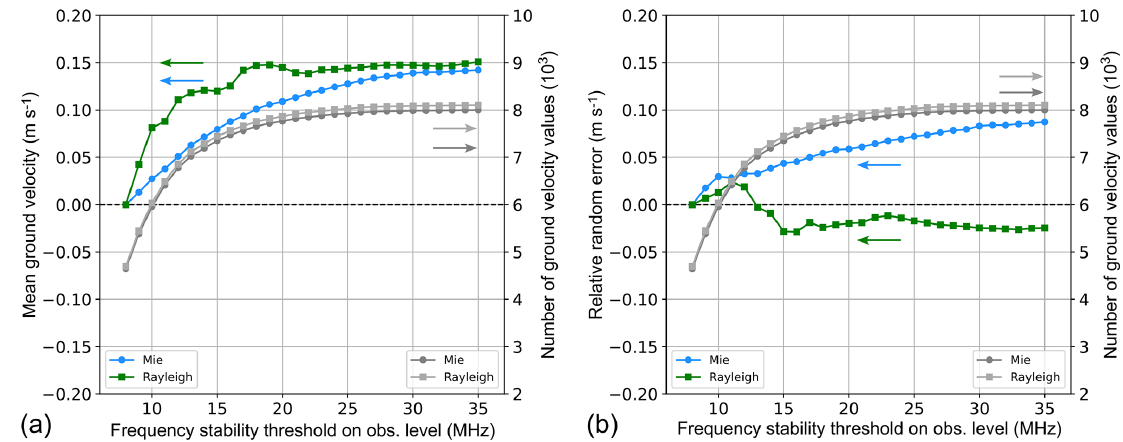
Figure 15. Mean ground velocity (a) and relative random error (b) of the Mie (blue dots) and Rayleigh channel (green squares) depending on a frequency stability threshold for the combined periods from 17 to 24 August 2020 and from 28 September to 5 October 2020. The data were subtracted by the respective values obtained for a threshold of 8MHz for the sake of comparability. The number of ground velocity values for which the frequency stability is below the threshold is shown in